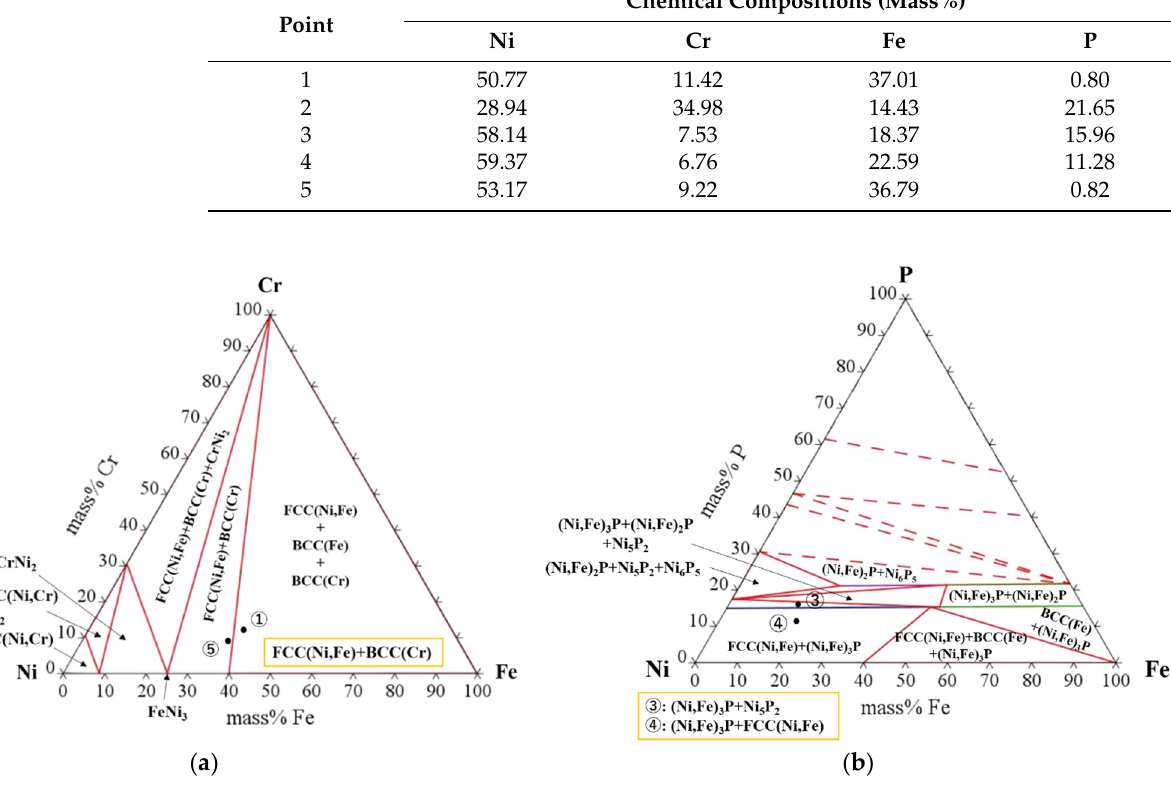
Figure 7. Phase diagrams of ternary Ni-Fe-Cr alloys ( a ) and Ni-Fe-P alloys ( b ) calculated by Therm-Clac 2021 (25 °C).